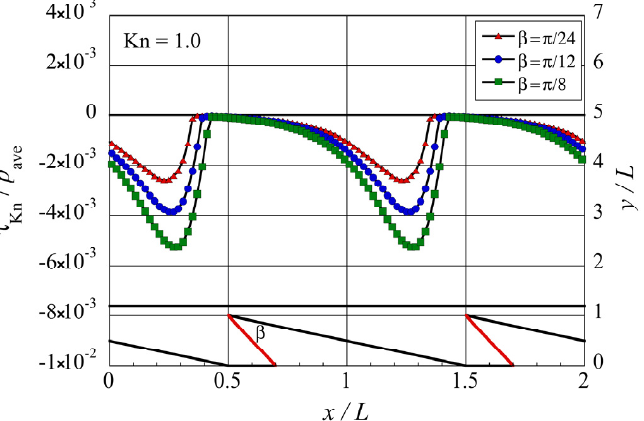
Figure 8. Distributions of the local tangential Knudsen stress due to molecules coming from the oblique side of the modified ratchet microstructure for different tip angles β at Kn = 1.